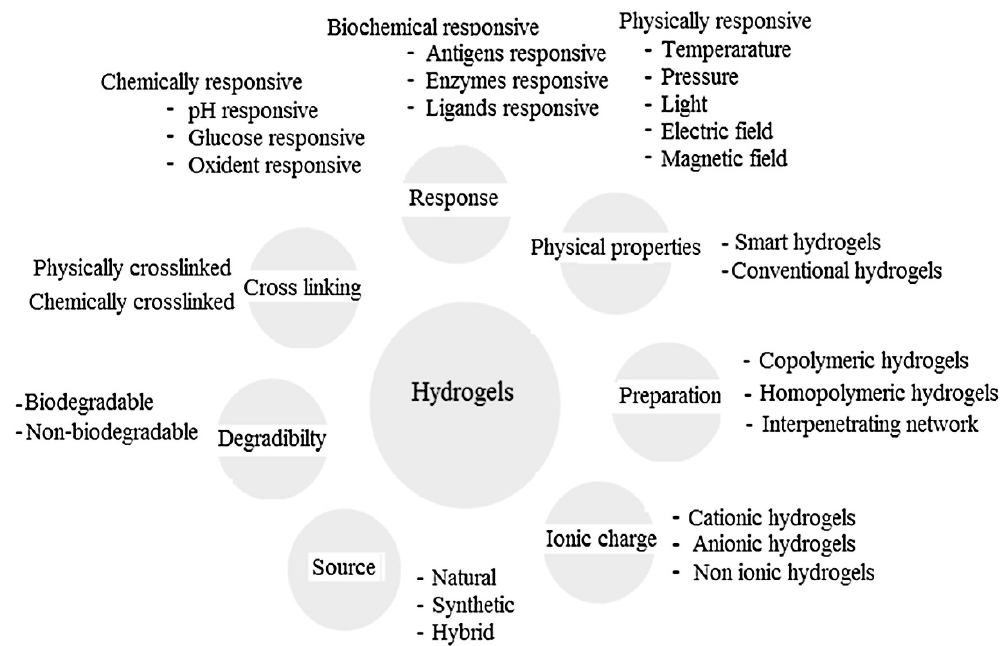
Figure 1. Hydrogels based on the different properties such as source, physical properties, crosslinking, ionic charge, response and degradability Reprinted from [17] with permission from Elsevier.